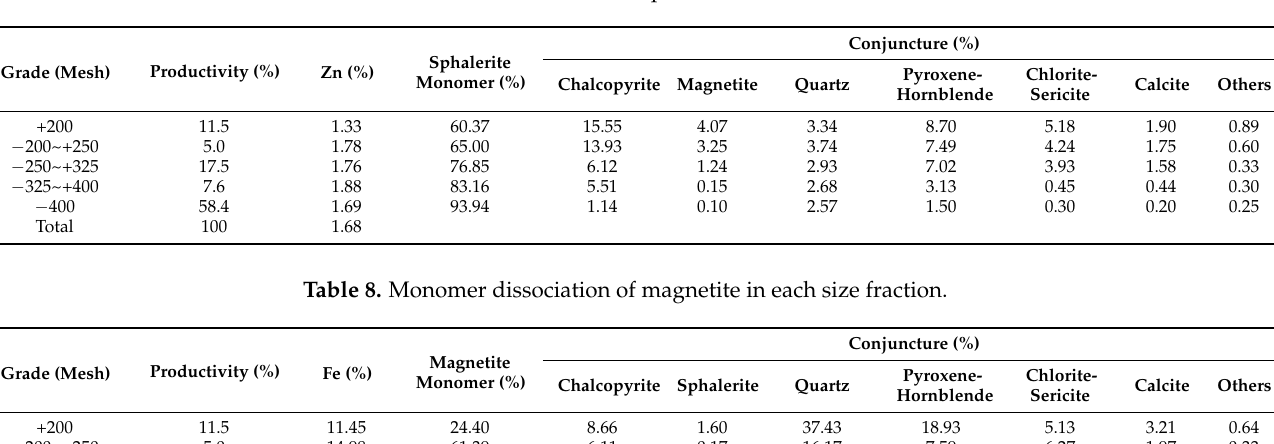
Table 7. Monomer dissociation of sphalerite in each size fraction.